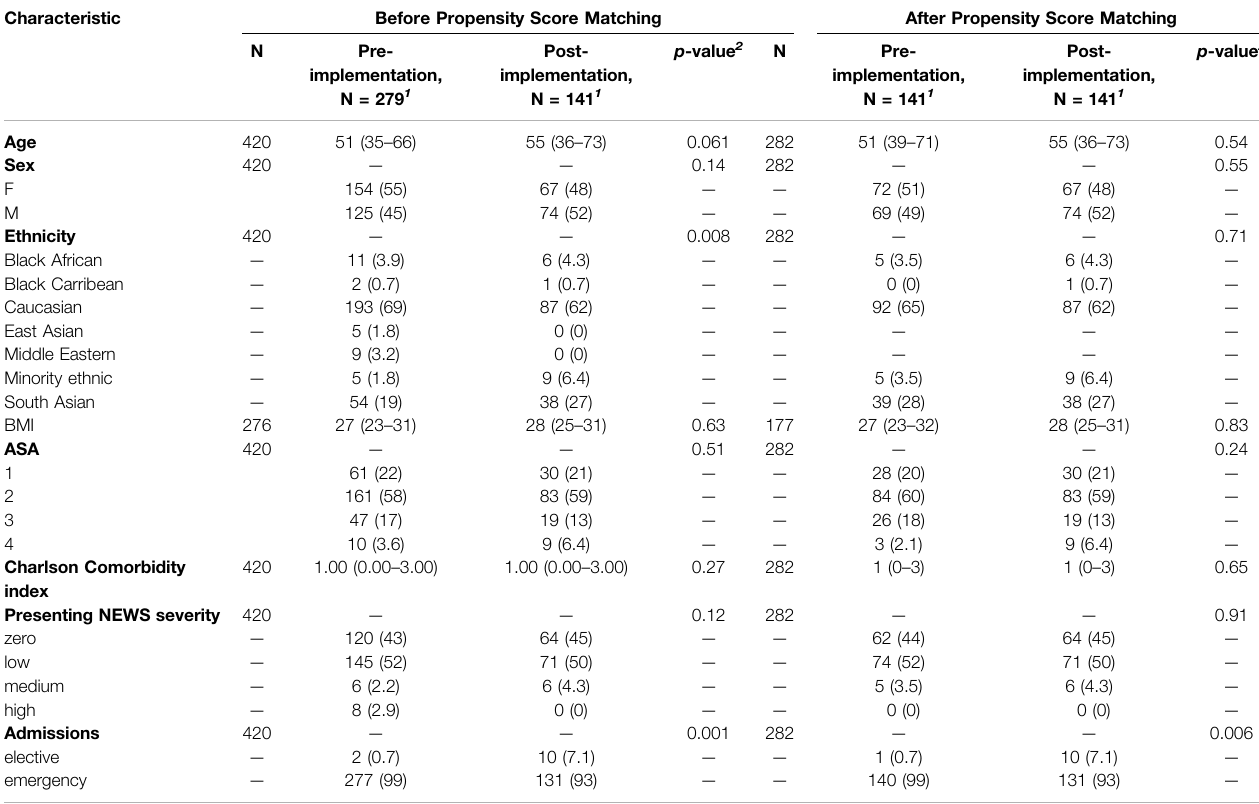
TABLE 1 | Baseline demographics before and after propensity score matching. Characteristic Before Propensity Score